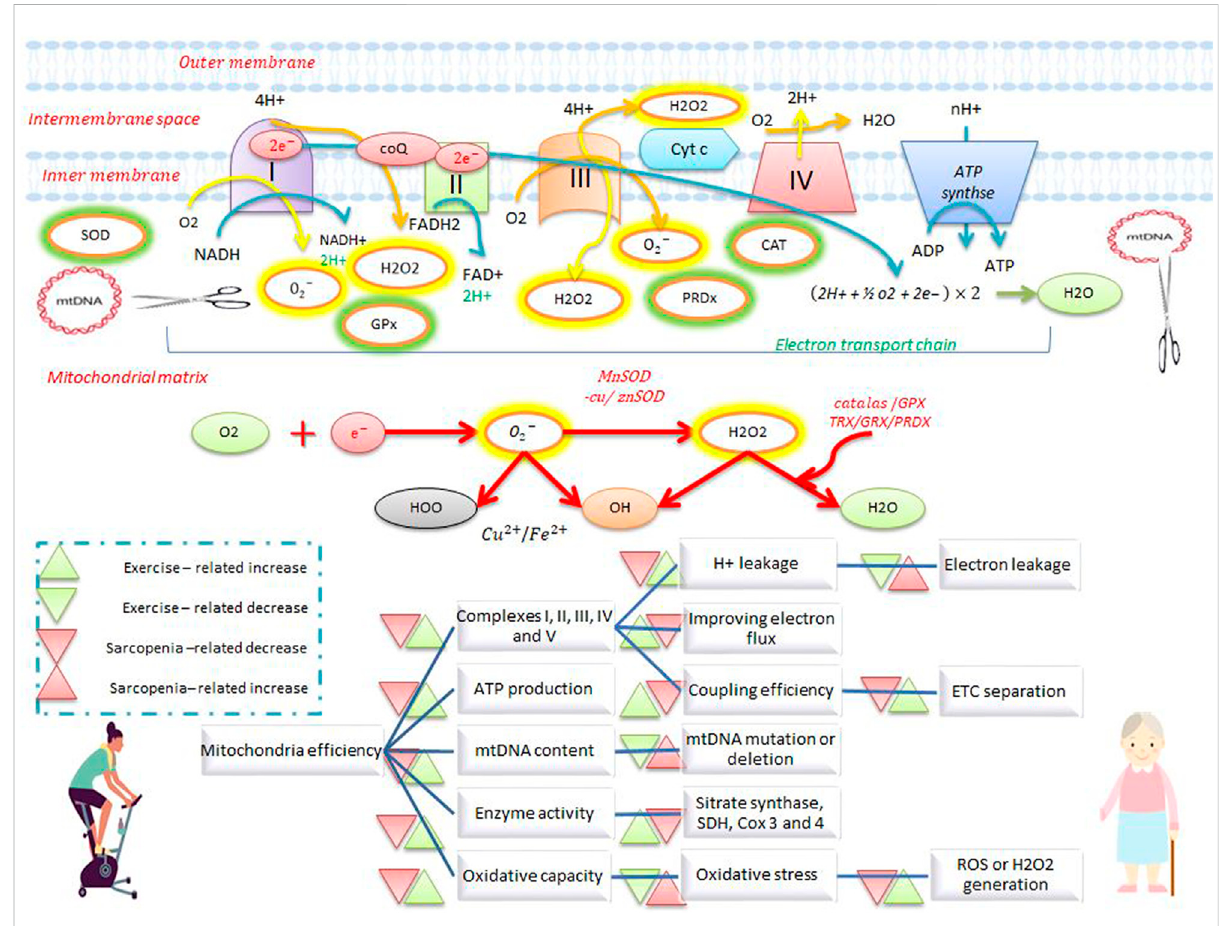
FIGURE 1 Electron transfer chain system and antioxidant defense during exercise and sarcopenia. Exercise increases the activity of complexes I, II, III, IV, and V, ATP production, enzymatic activity, oxidative capacity, and mtDNA repair, and reduces electron leakage, electron transfer chain separation, and ROS production. Exercise also stimulates antioxidant defenses by increasing antioxidants such as catalase, superoxide dismutase, and peroxiredoxin. Exercise opposes the effects of sarcopenia on mitochondrial activity and antioxidant